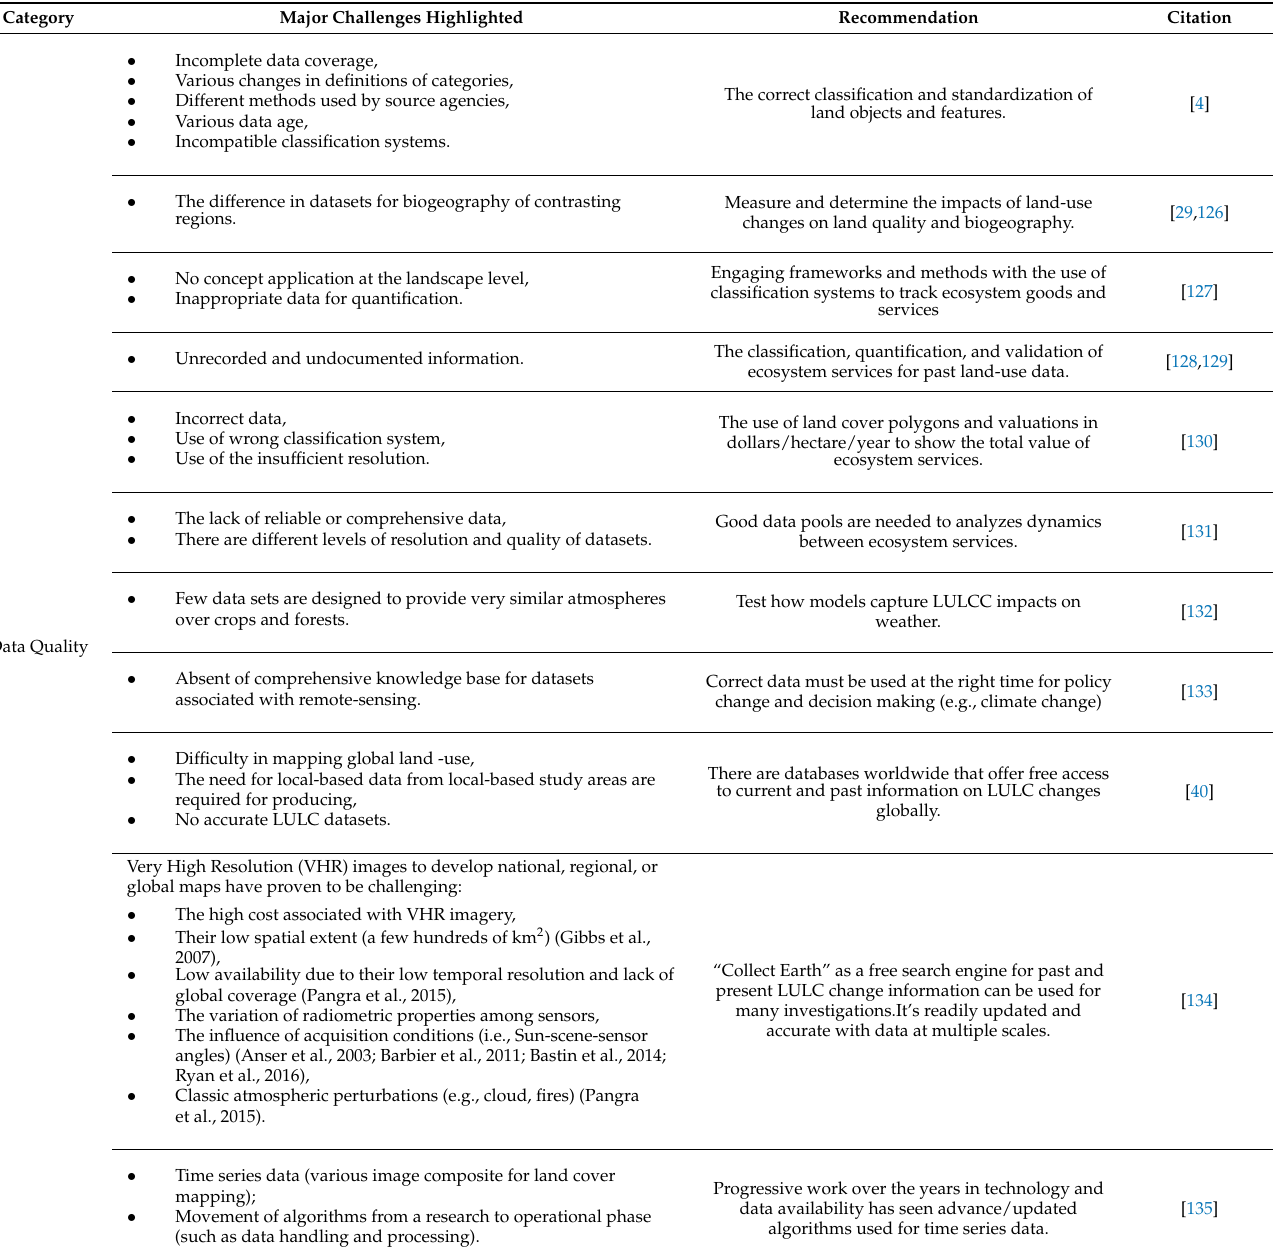
Table 4. Showing significant challenges and